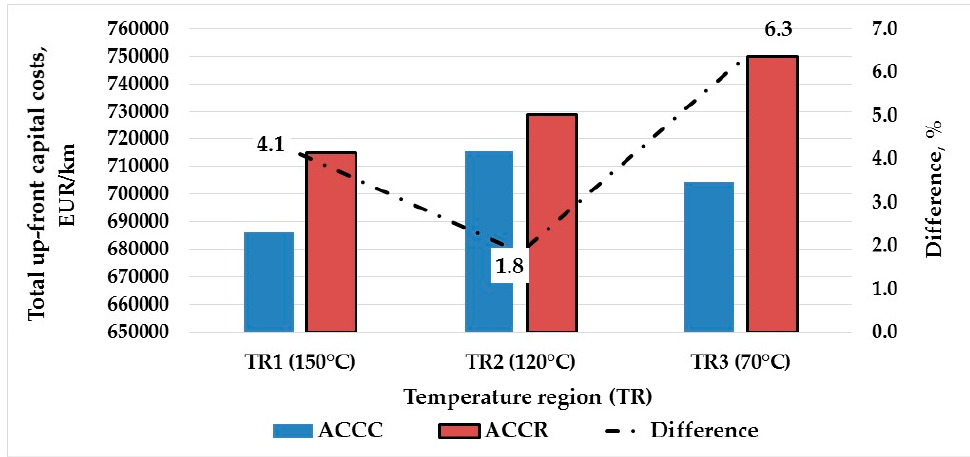
Figure 13. Total up-front capital costs for reconstruction of existing power line for “OHL No.1” case.